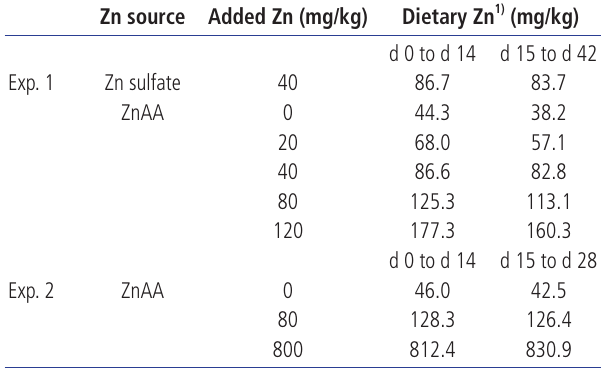
Table 1. Composition and chemical composition of the basal diets (as-fed basis) Items